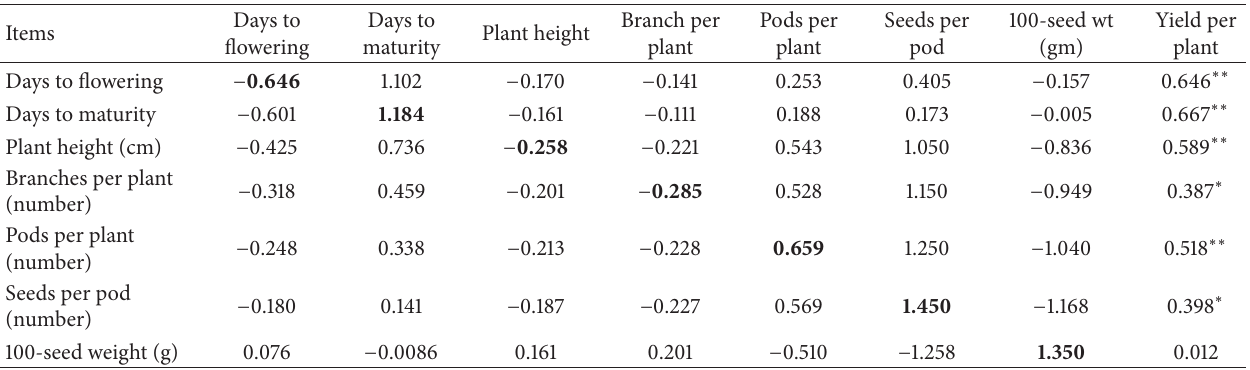
Table 7: Partitioning of genotypic correlations into direct (bold) and indirect effects of eight morphological traits in 31 soybean genotypes by path analysis.